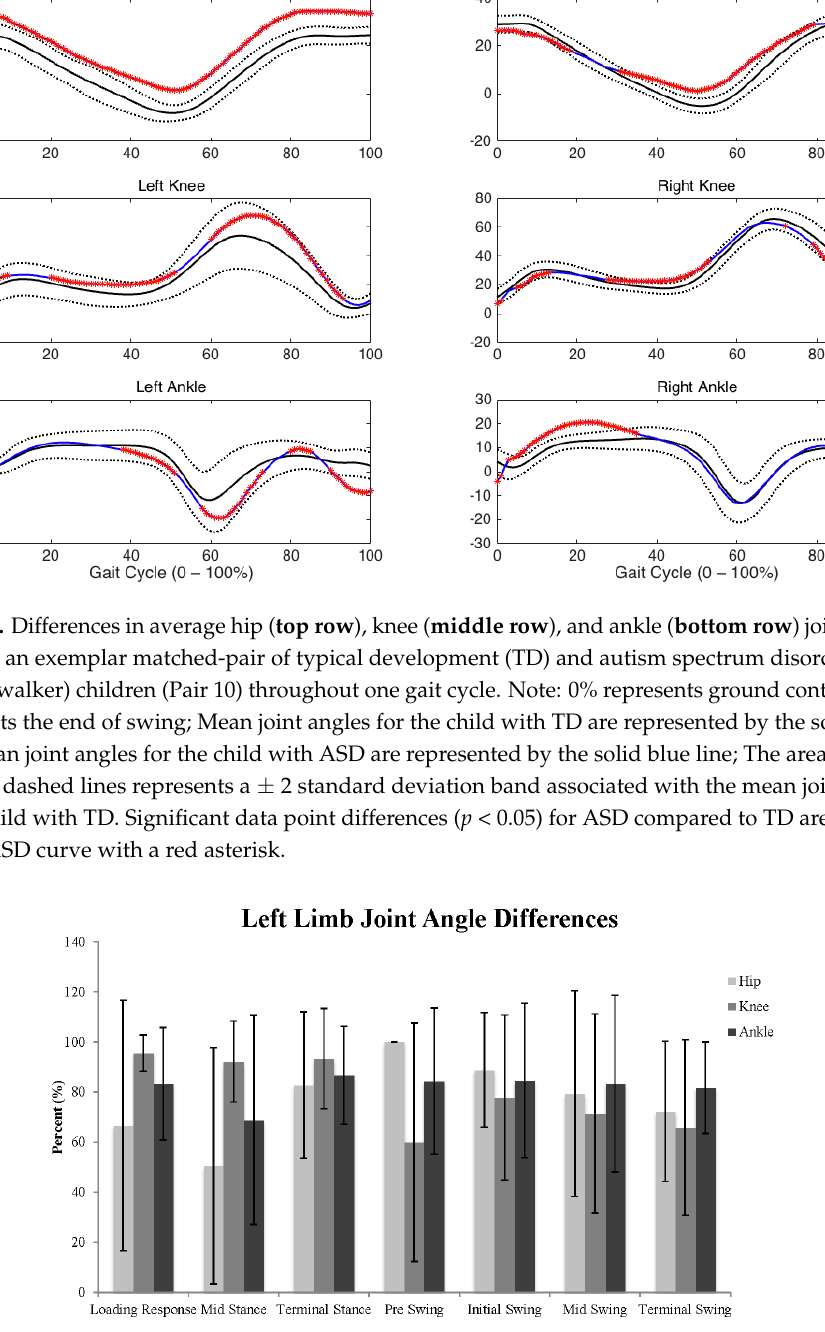
Figure 2. Mean ± one standard deviation of the number of significant sagittal plane joint angle differences (expressed as a percentage of the gait cycle sub ‐ phase) between TD and ASD children averaged across the 10 matched pairs for the left and right hip, knee, and ankle joints. Table 1. Percentages of significant differences observed for hip, knee, and ankle position by Gait Phase, Limb and Matched Participant Pair. Hip Position